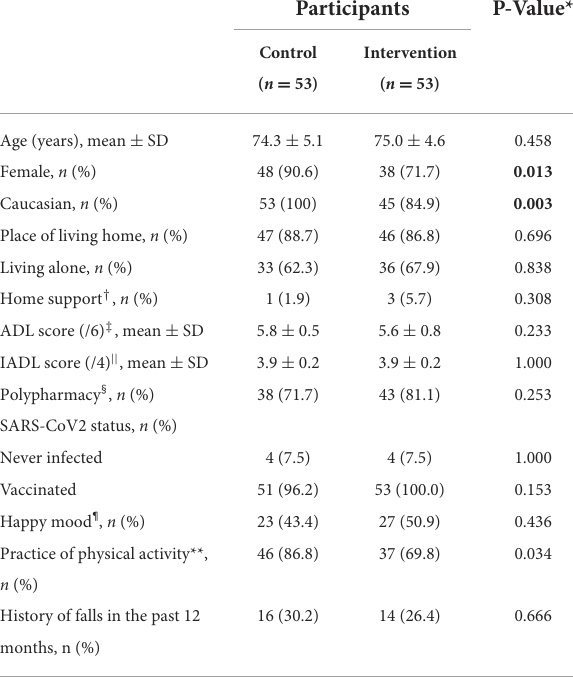
TABLE 1 Baseline participant characteristics ( n =